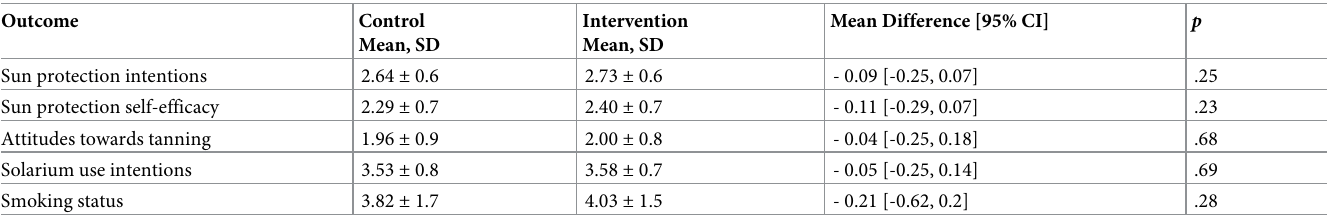
Table 2. Mean primary and secondary outcome scores at follow-up (Mann-Whitney tests).